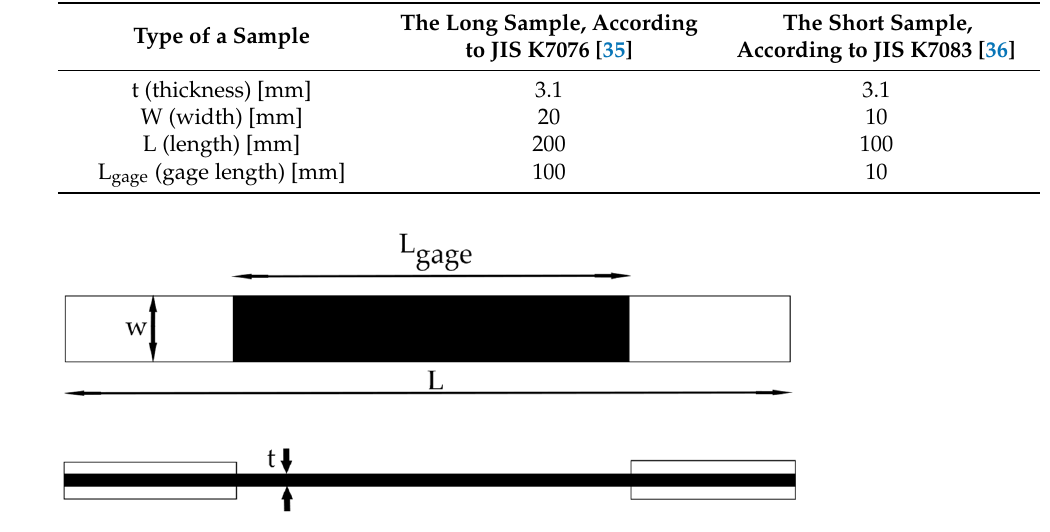
Figure 5. The samples geometry.